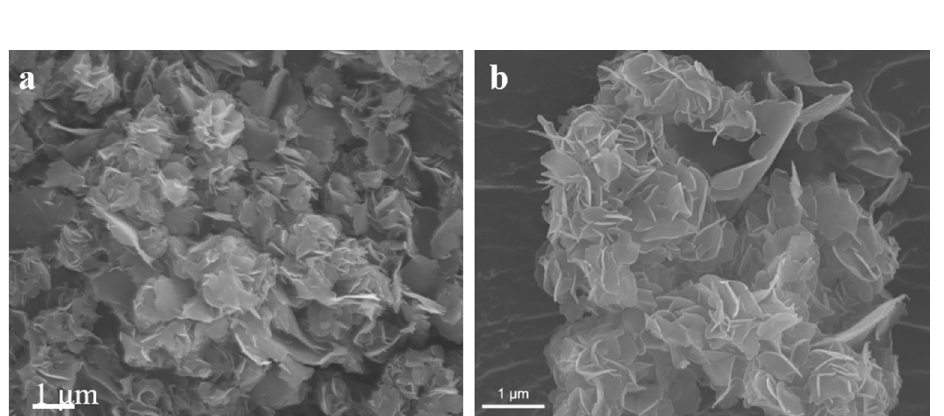
Figure 5. SEM image of ( a ) starting material VSe 2 NSs. ( b ) Final product Cu 3 VSe 4